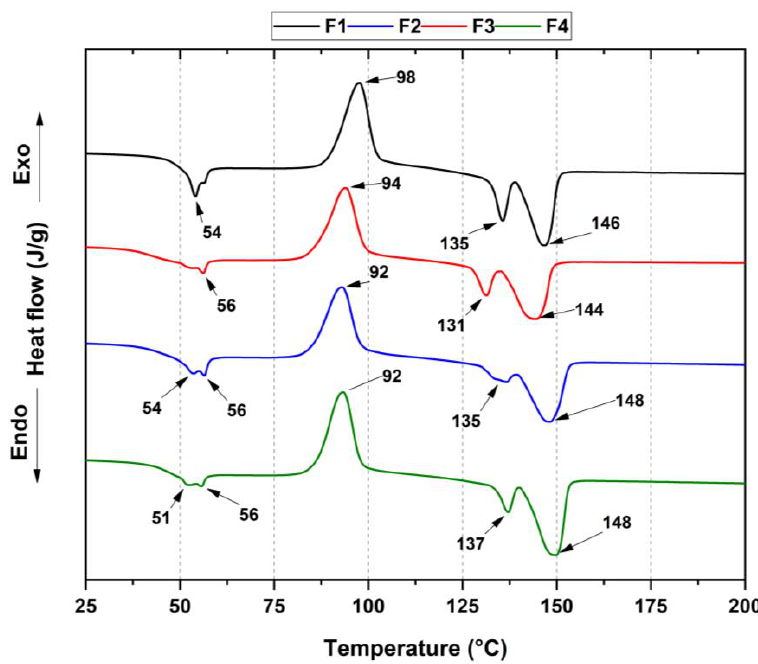
Figure 5. DSC thermogram for the membranes PCL/PLA/TiO 2 /OEO. F1, 30% PCL/70% PLA; F2, 27% PCL/70% PLA/3% TiO 2 ; F3, 20% PCL:70% PLA:10% OEO; F4, 17% PCL:70% PLA:3% TiO 2 :10% OEO. Table 2. Thermal properties of membranes PCL/PLA/TiO 2 /OEO. F1, 30% PCL:70% PLA; F2, 27%